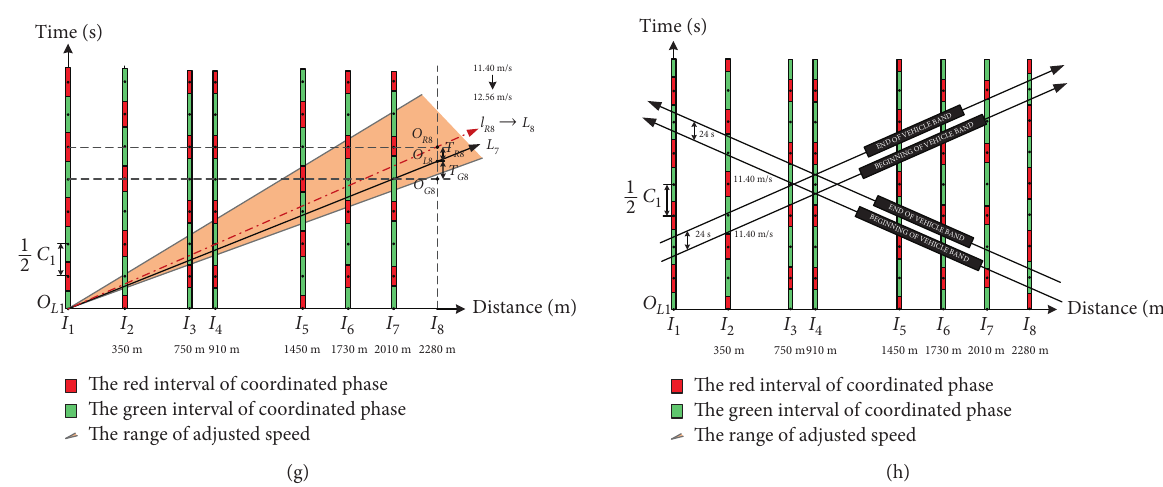
The green interval of coordinated phase The range of adjusted speed